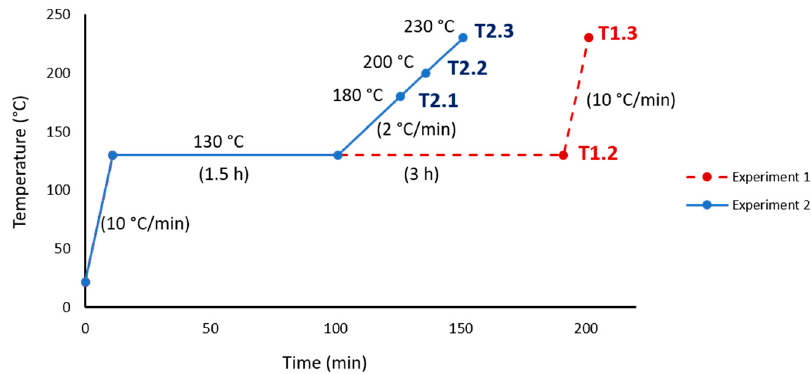
Figure 3. Thermal cycle of Experiment 2. Tested temperatures were 180, 200 and 230 °C without holding times. The first temperature increase was 10 °C/min, the second was 2 °C/min. The dashed line shows the thermal cycle of Experiment 1 until point T1.3 for comparison.